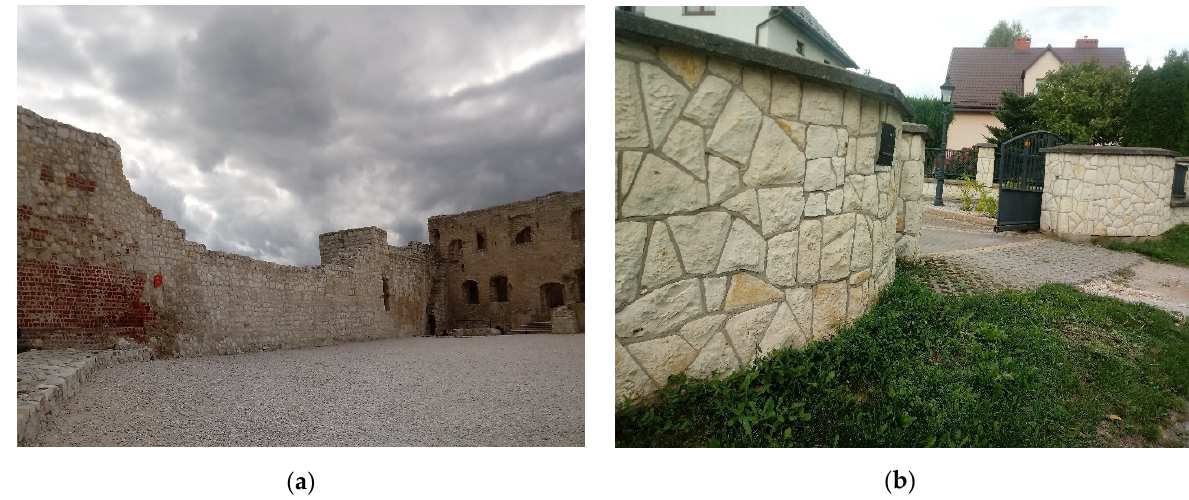
Figure 3. ( a ) The walls of the Castle in Kazimierz Dolny on the River Vistula, made of opoka rock. 14th century; ( b ) Con- temporary use made of opoka rocks from the Bochotnica region (author’s own elaboration).